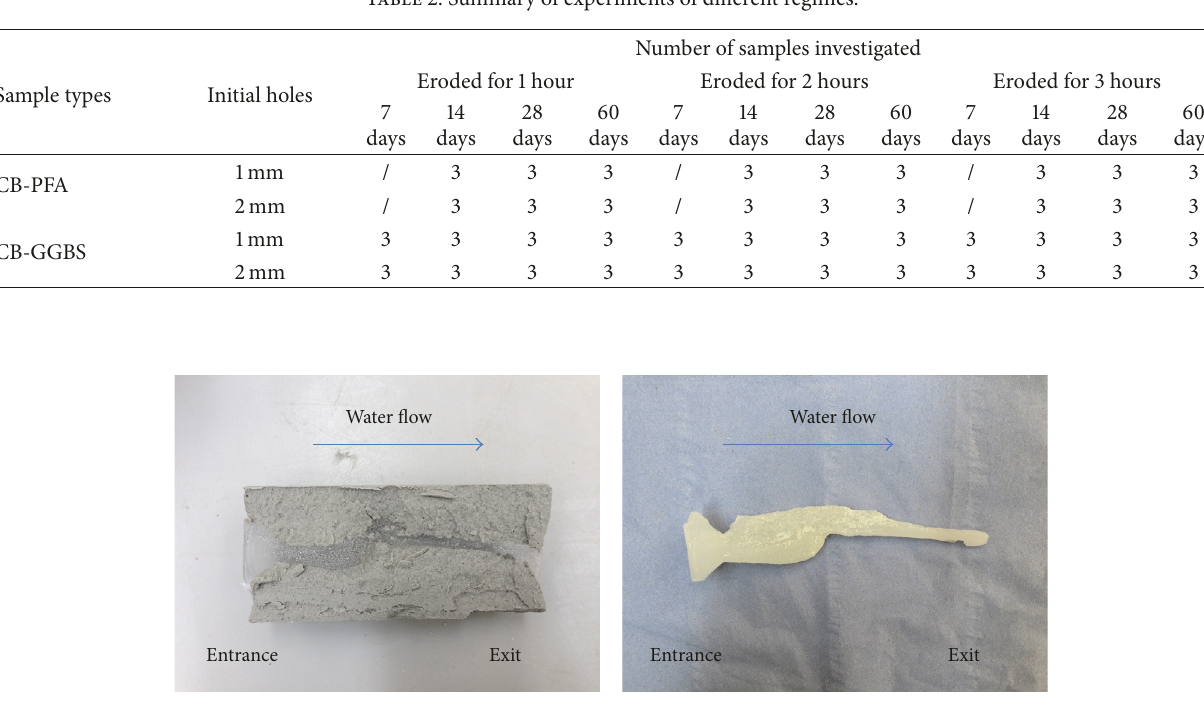
Table 2: Summary of experiments of different regimes.